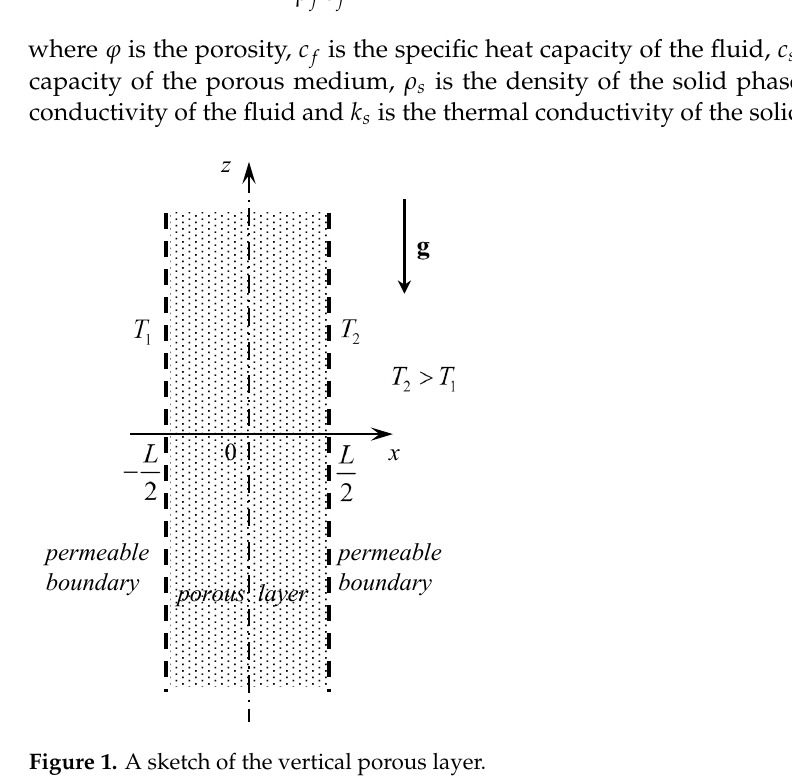
Figure 1. A sketch of the vertical porous